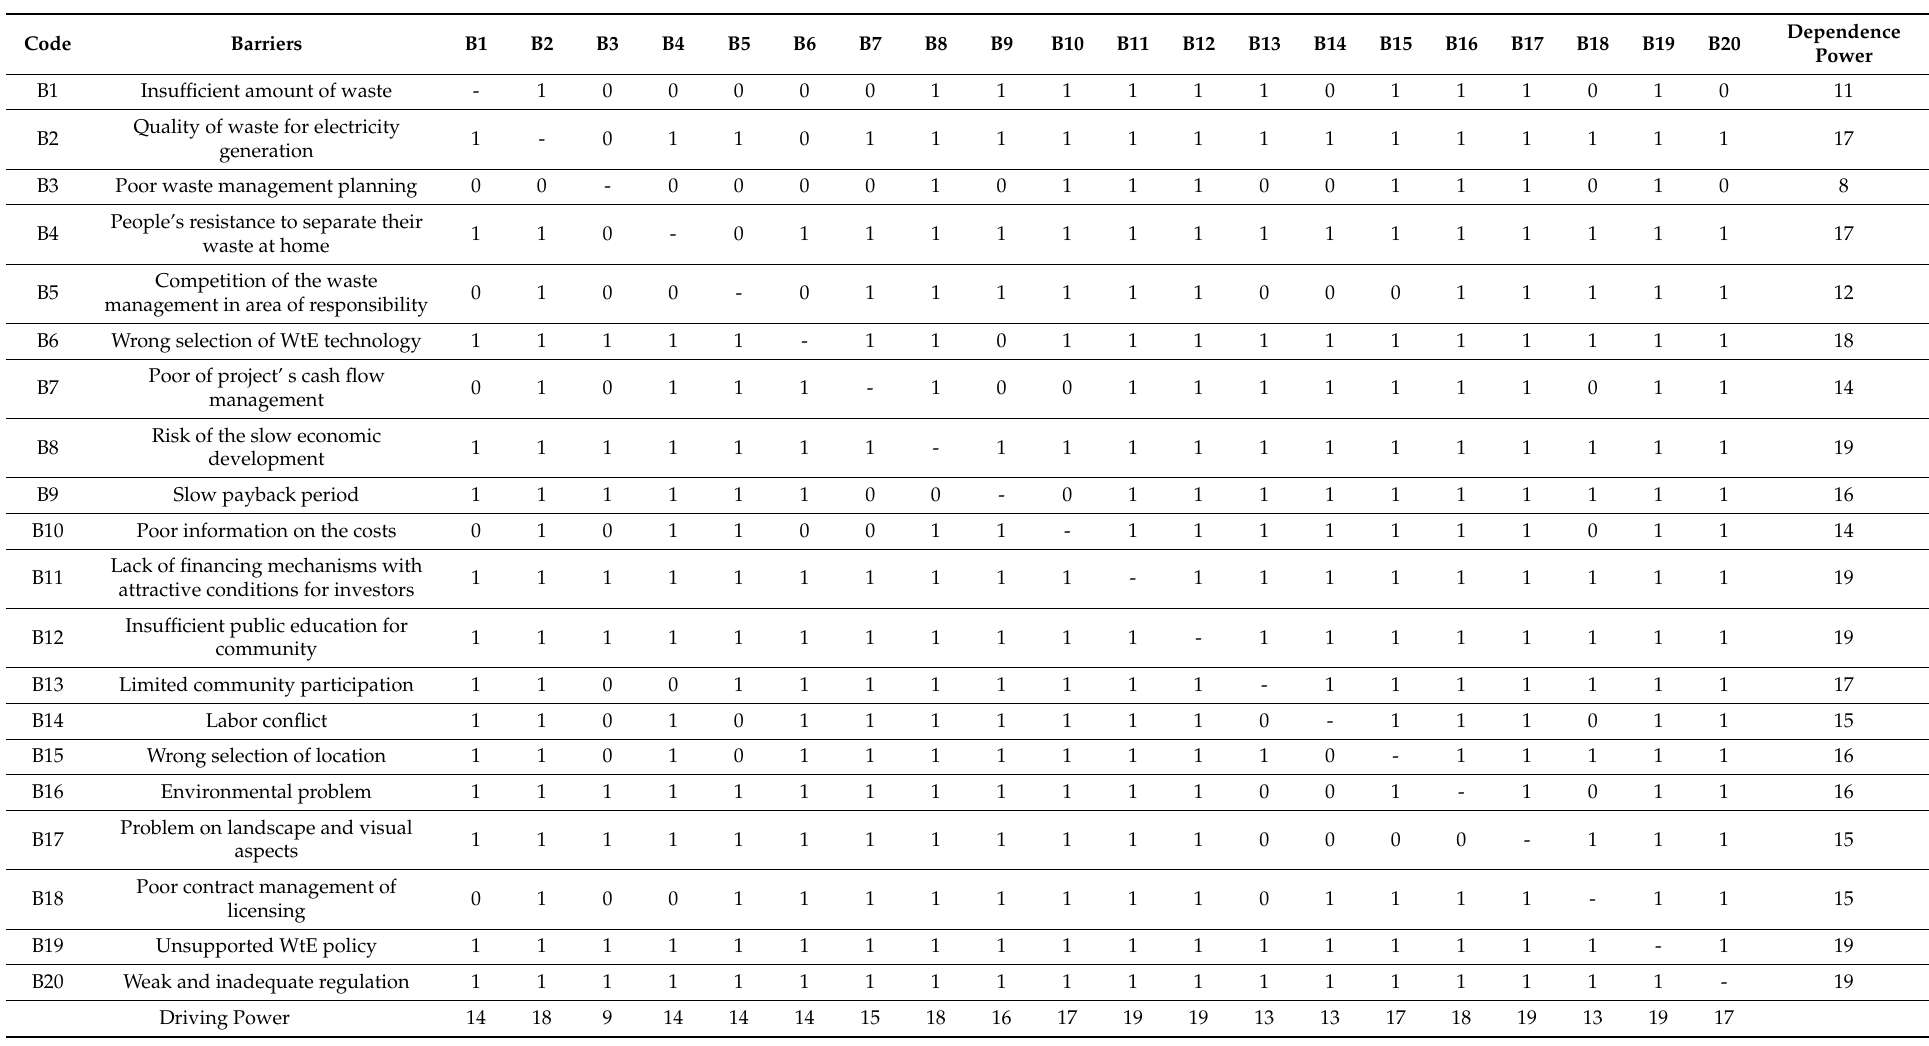
Table 5. The reachability matrix of this